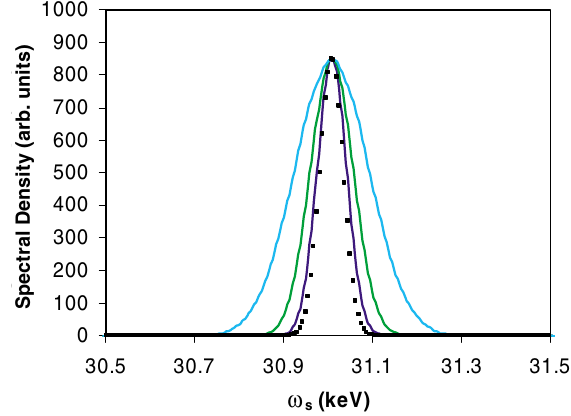
FIG. 8. (Color) On-axis x-ray spectrum produced by a (cid:15) (cid:2) 100 electron colliding side on with an 800 nm laser pulse with a bandwidth corresponding to a 0.5 ps 1 =e 2 pulse width for the case of a plane wave (dots), 200 (cid:18) m laser focus (dark blue line), 100 (cid:18) m laser focus (green line), and 50 (cid:18) m laser focus (light blue